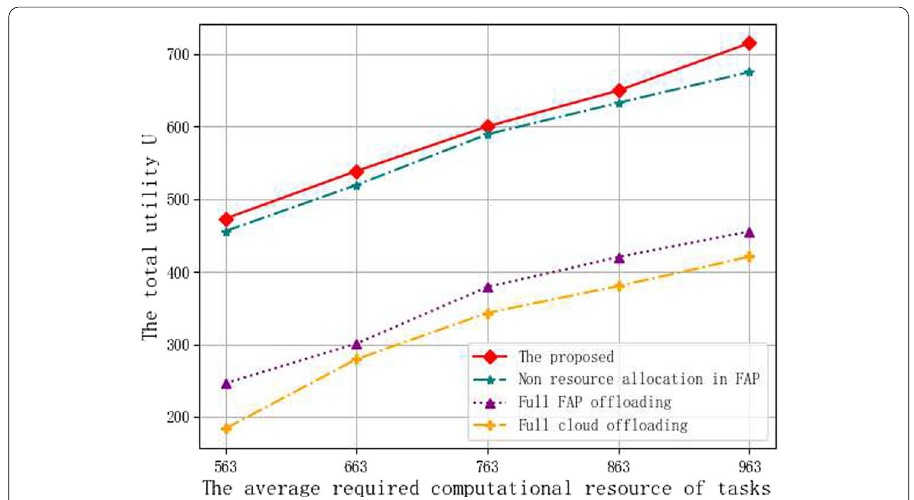
Fig. 12 The total utility of UEs over the average required computational resource of